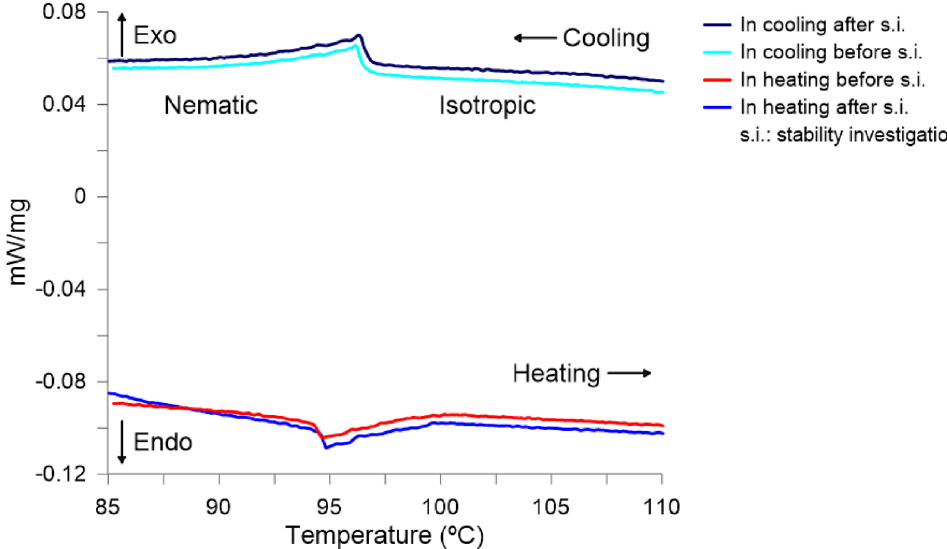
Figure 7. DCS thermographs upon heating/cooling cycles of mixture 1929.